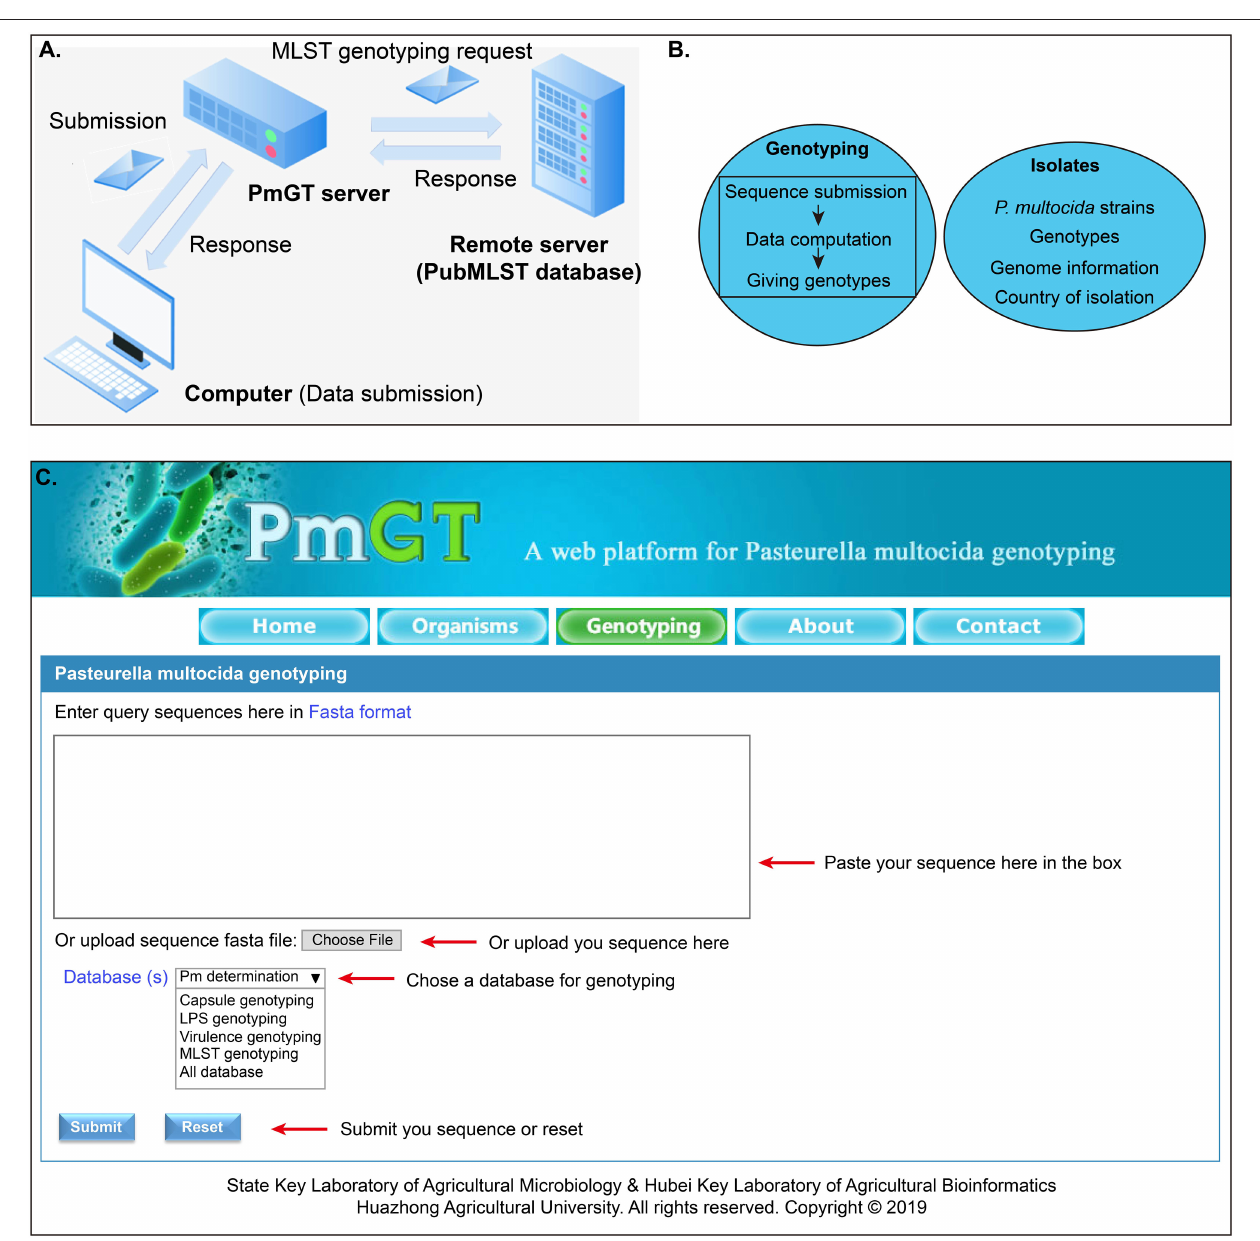
FIGURE 1 | Development of the P. multocida genotyping and host prediction platform. (A) Flowchart showing the system design; (B) Main functions of the web platform; (C) Overview of the genotyping system of P. multocida .